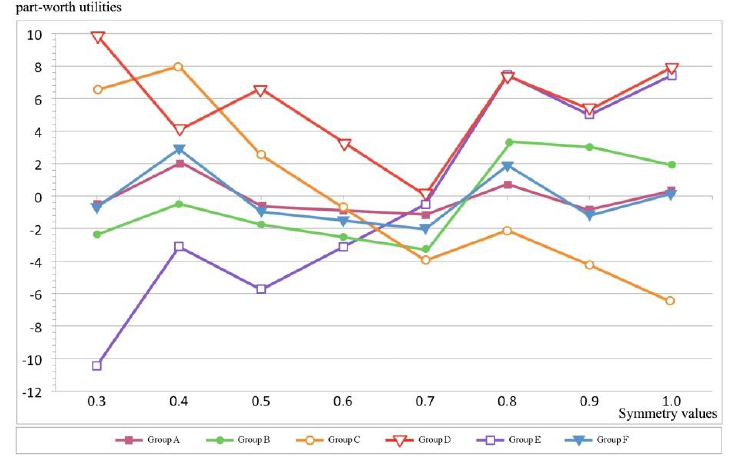
Figure 8. Part − worth utilities of different Symmetry values for the six groups.